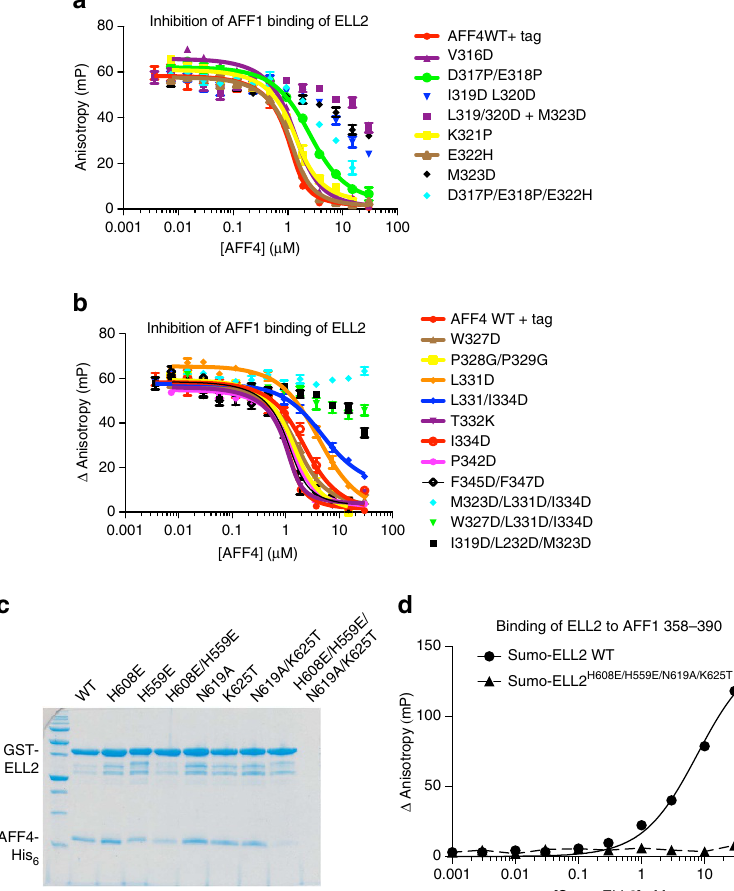
Figure 5 | Contributions of AFF4 ELLBow interactions to binding in solution. ( a ) Binding of AFF4 ELLBow wild type (WT) and mutants in the N-terminal a -helix to Sumo-ELL2 Occ . Sumo-ELL2 Occ binding to fluorescently labelled AFF1 ELLBow peptide 358–390 is competitively inhibited by increasing amounts of AFF4 ELLBow , as described in experimental procedures. Error bars reflect the s.e. from three experimental replicates in a , b . ( b ) Binding of AFF4 ELLBow WTand mutants in the central cluster and elbow joint, assayed as in a . ( c ) GST fusions of the indicated ELL2 Occ mutants were immobilized and their ability to pull-down His 6 -tagged WT AFF4 ELLBow assessed. An uncropped version of this pull-down gel is shown in Supplementary Fig. 4. ( d ) Direct binding of WTand mutant Sumo-ELL2 to fluorescently labelled AFF1 ELLBow peptide. The assay was performed in triplicate. The s.e. from the three replicates in d is smaller than the symbols used to plot the data